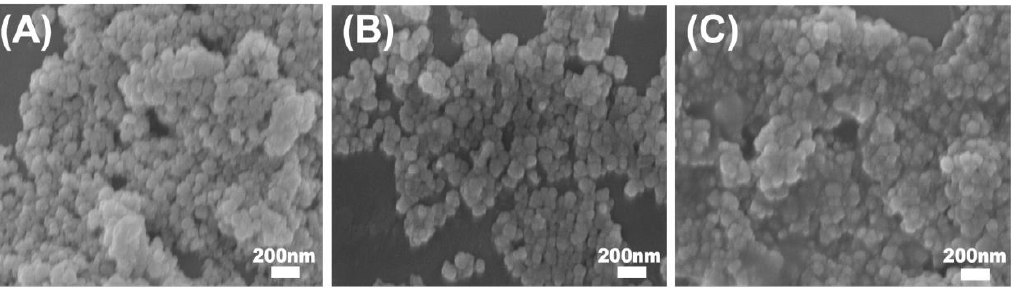
Figure 3. SEM images of TiO 2 ( A ), TiO 2 -g- PNIPAM ( B ) and ZnPc -g- TiO 2 -g- PNIPAM ( C ).